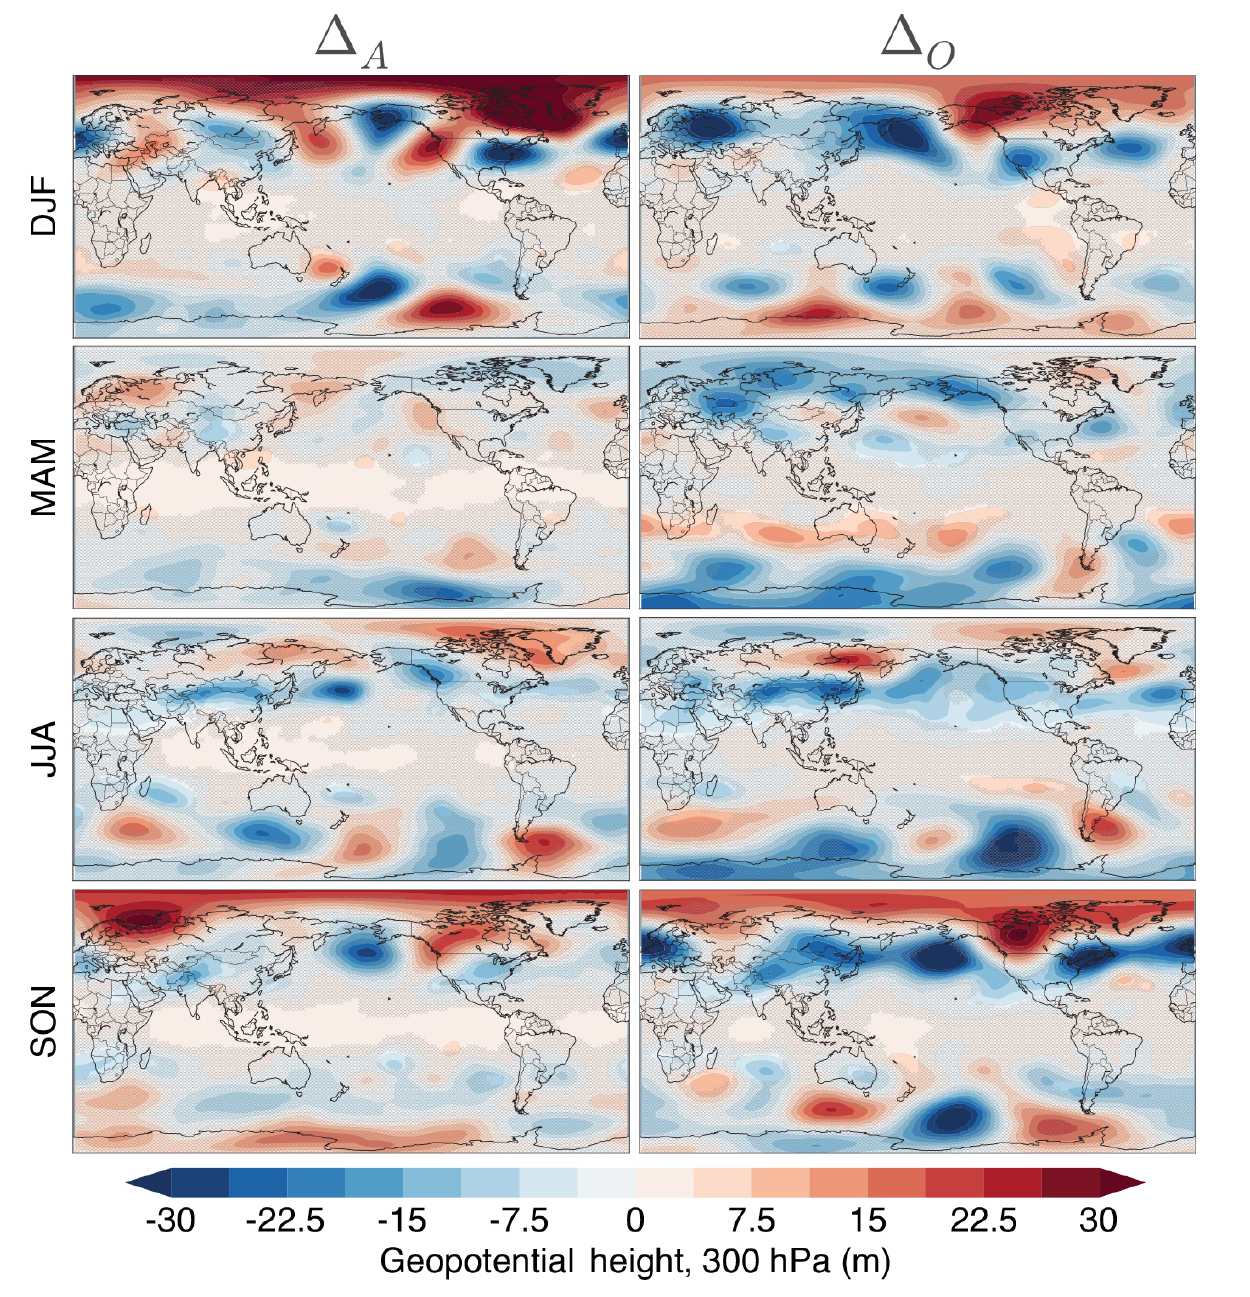
Figure 5. Same as Fig. 3 but for 300mb height differences